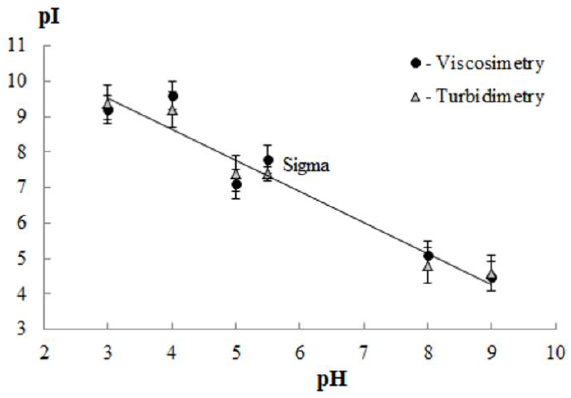
Figure 1. Effect of extraction pH on the isoelectric point (pI) of gelatin. Data were obtained by the methods of turbidimetry and capillary viscometry.